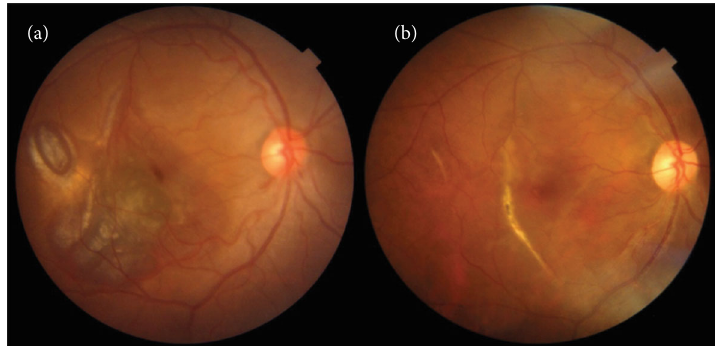
Figure 3: Preoperative and 6-month postoperative fundus color photographs. (a) Submacular hemorrhage associated with an adjacent parafoveal choroidal rupture. (b) Six months after surgery: a clinically normal foveal appearance and subretinal reparative scarring along the choroidal rupture temporal to the fovea.